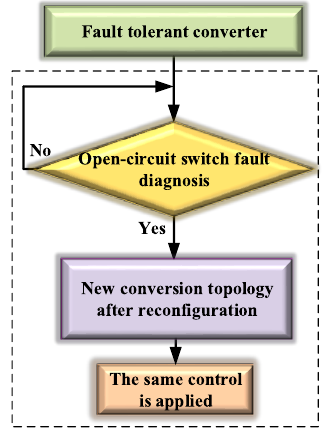
Figure 3. The proposed service continuity approach.